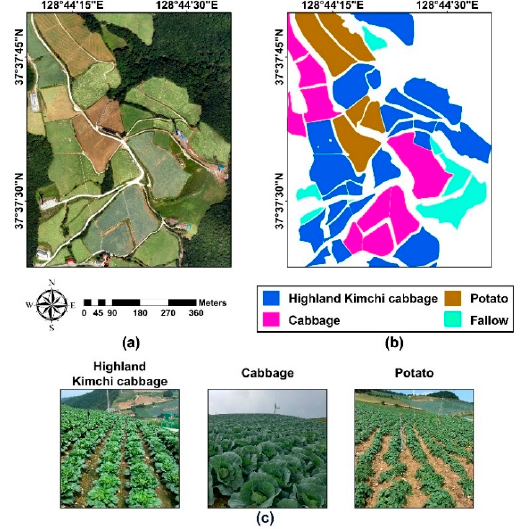
Figure 1. Datasets used for crop classification in Anbandegi: ( a ) true color unmanned aerial vehicle (UAV) imagery; ( b ) ground truth map; and ( c ) field photos.